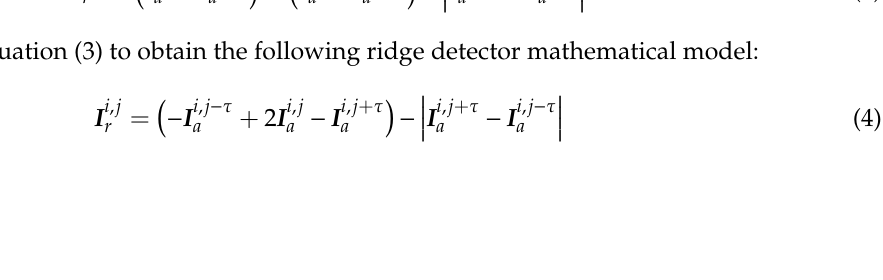
Figure 4. Ridge detector illustration. ( a ) ridge point illustration. ( b ) Equation (2) illustration